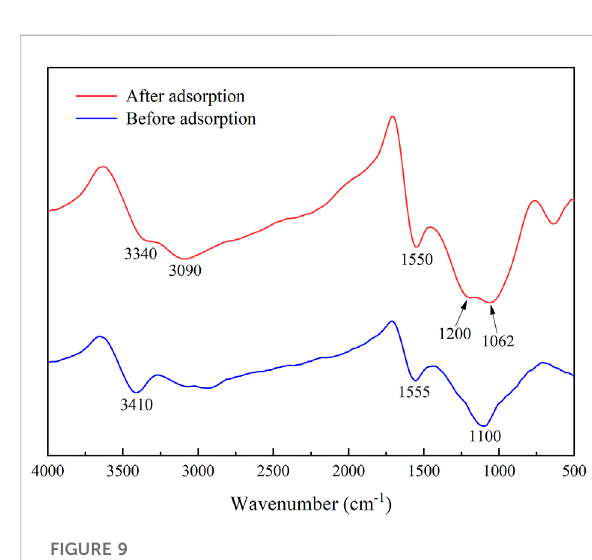
FIGURE 9 FT-IR spectra of IKBCH before and after TC